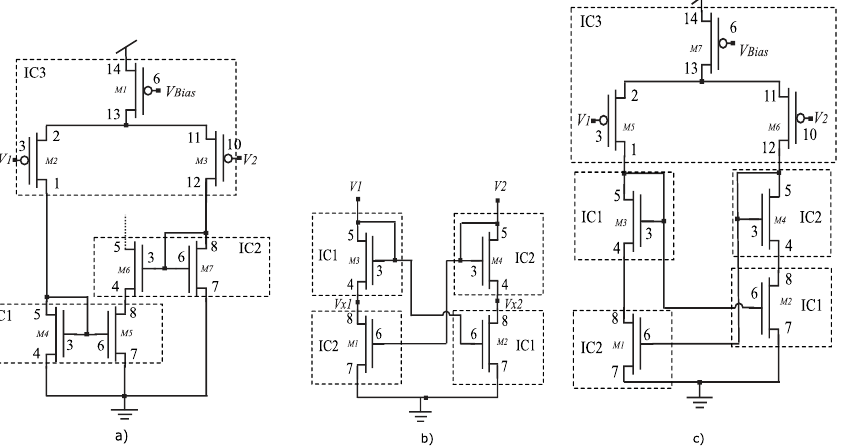
Figure 19. Pin numbers and connections diagram for the IC CD 4007 UBE to realize ( a ) the classic bump using 2 ICs ( b ) voltage correlator using 3 ICs and ( c ) the proposed bump connection using 3 ICs. Bulks of NMOS are connected to GND and PMOS to VDD .